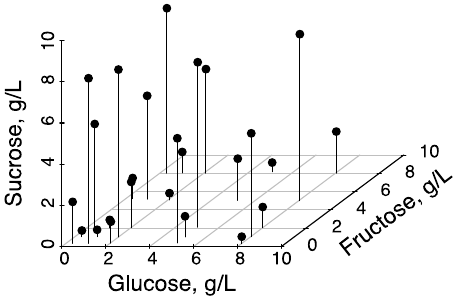
Figure 2. 3D plot of the three sugars’ concentrations, established by the fractional factorial design.